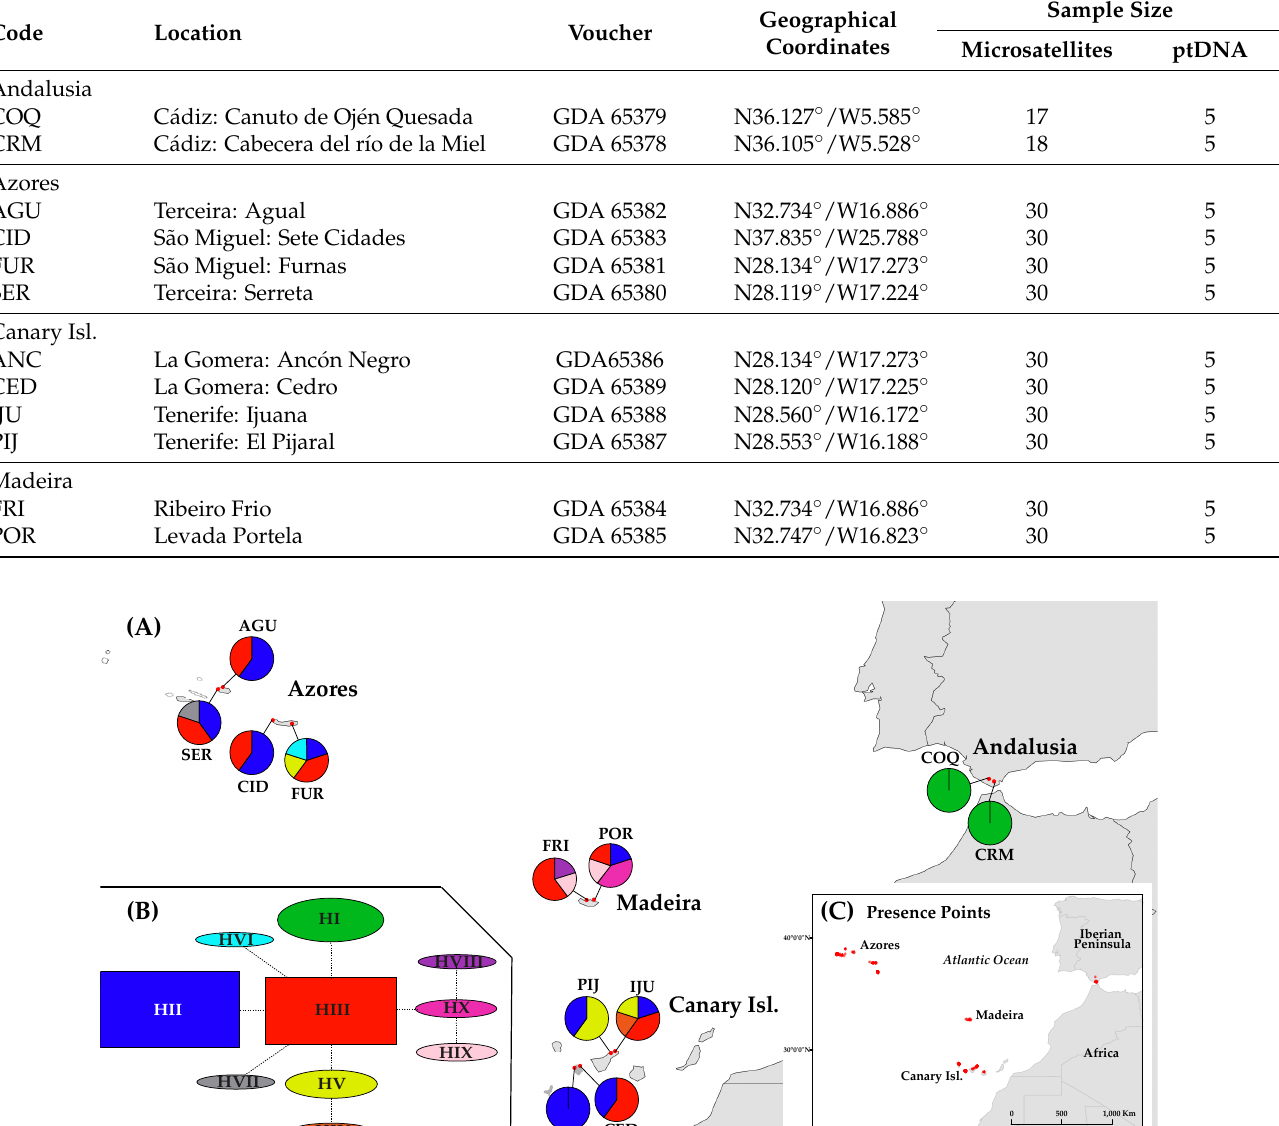
Table 1. Sampling details of D. caudatum populations used in the present study.